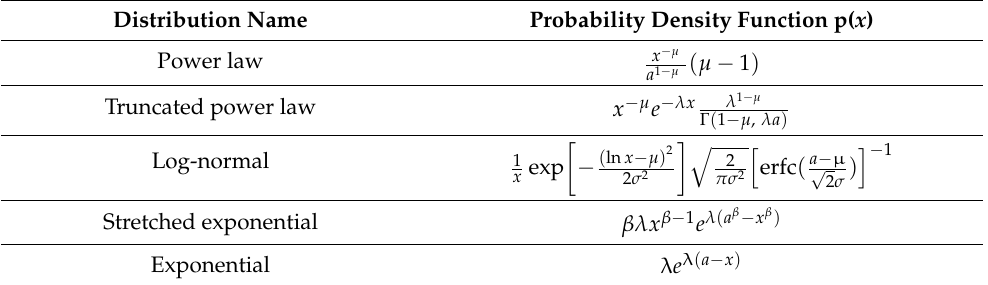
Table A1. Distributions used in model comparison. Here, x is observed data, a is the minimal data point, Γ is upper incomplete gamma function, erfc is complementary error function, and µ , λ , σ , β are parameters of the corresponding distributions.